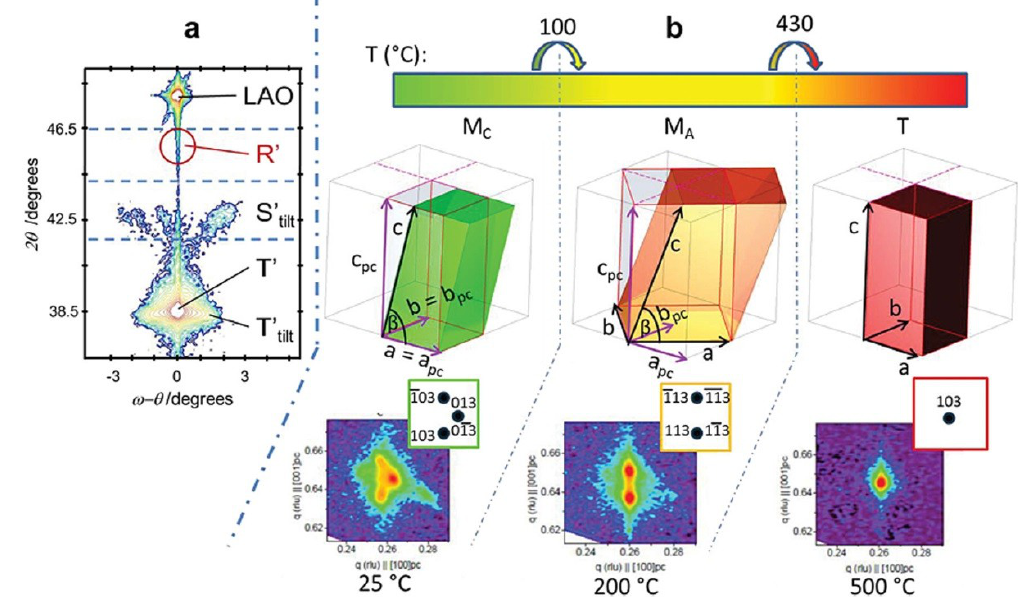
Figure 10. ( a ) X-ray diffraction map for a 45-nm thick BFO film on LAO, the peaks of the LAO substrate, and the polymorphs of film (S’ dependence of the structure of the T’ polymorph. (Reprinted with permission from